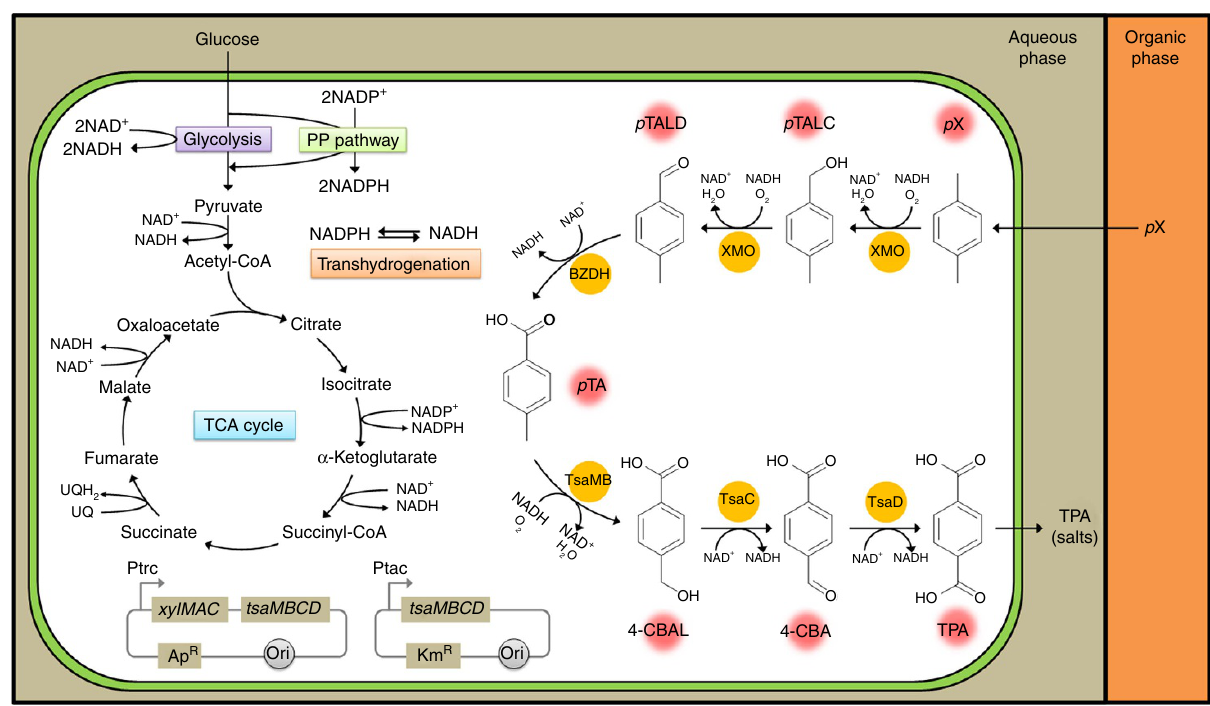
Figure 1 | Biotransformation pathway from p X to TPA and the central carbon metabolism of E. coli . Glucose and p X are transported into the cell from the aqueous and organic (OA) phases, respectively. The synthetic pathway biotransforming p X to TPA is shown on the right side of the cell. The synthetic pathway was established in E. coli through the introduction of two plasmids system shown at the bottom. TPA produced is excreted from cells into the aqueous phase in the form of TPA di-salts at the culture pH of 7.0 employed during the two-phase fermentation. The redox cofactor-related reactions are also indicated. BADH, benzyl alcohol dehydrogenase; BZDH, benzaldehyde dehydrogenase; 4-CBA, 4-carboxybenzaldehyde; 4-CBAL, 4-carboxybenzyl alcohol; NAD þ , nicotinamide adenine dinucleotide oxidized form; NADH, nicotinamide adenine dinucleotide reduced form; p TA, p -toluic acid; p TALC, p -tolualcohol; p TALD, p -tolualdehyde; p X, p -xylene; TPA, terephthalic acid; TsaC, 4-CBAL dehydrogenase; TsaD, 4-CBA dehydrogenase; TsaMB, toluate methylmonooxygenase; XMO, xylene